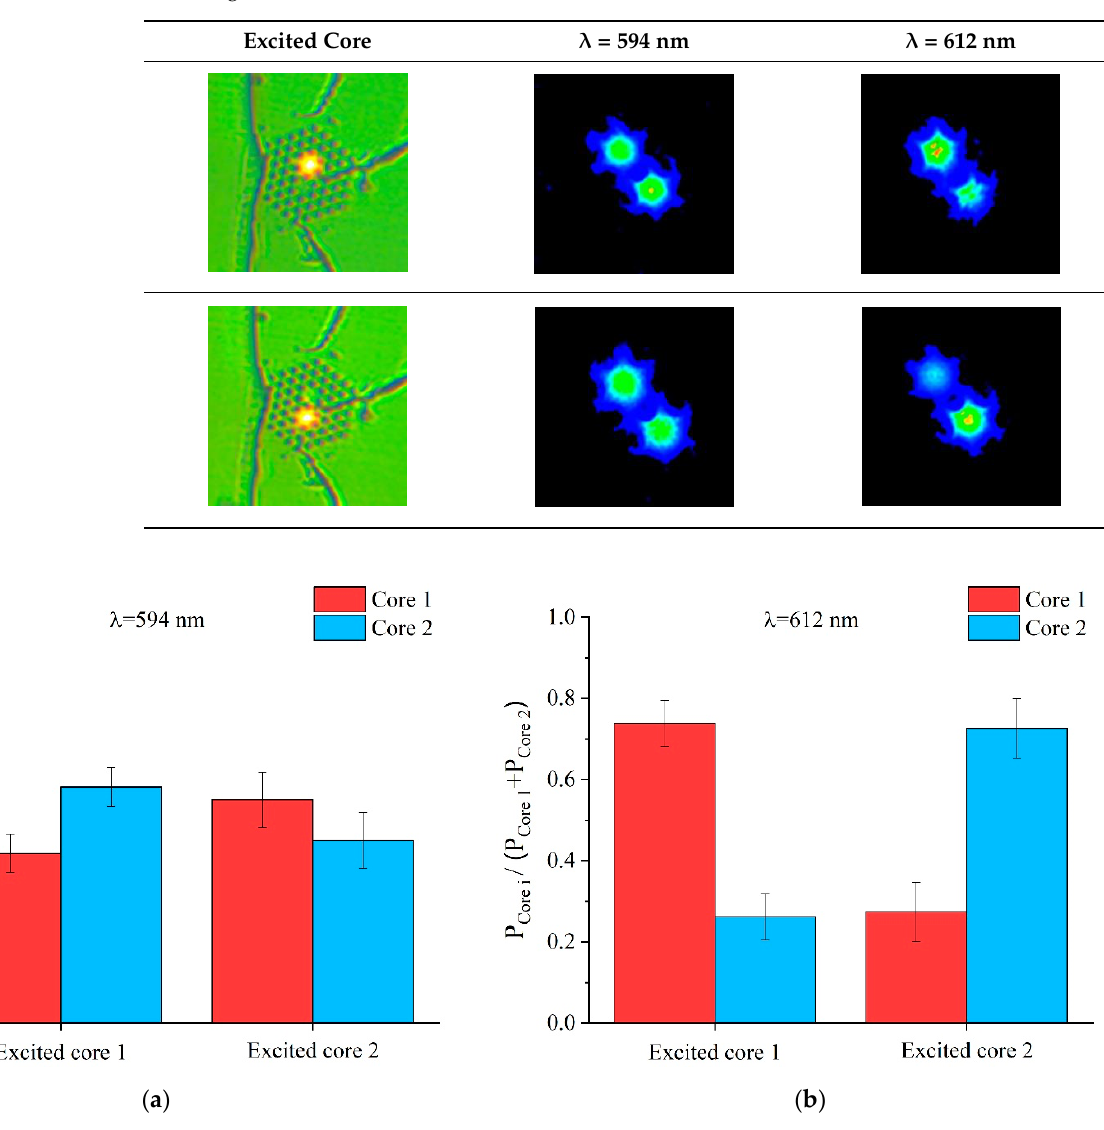
Table 1. Excited core: images of the fiber cross-section with the laser light exciting each core of the dual-core mPOF; λ = 594 nm: near fields at the output end-face of the fiber for an excitation wavelength of 594 nm; λ = 612 nm: near fields at the output end-face of the fiber for an excitation wavelength of 612 nm.